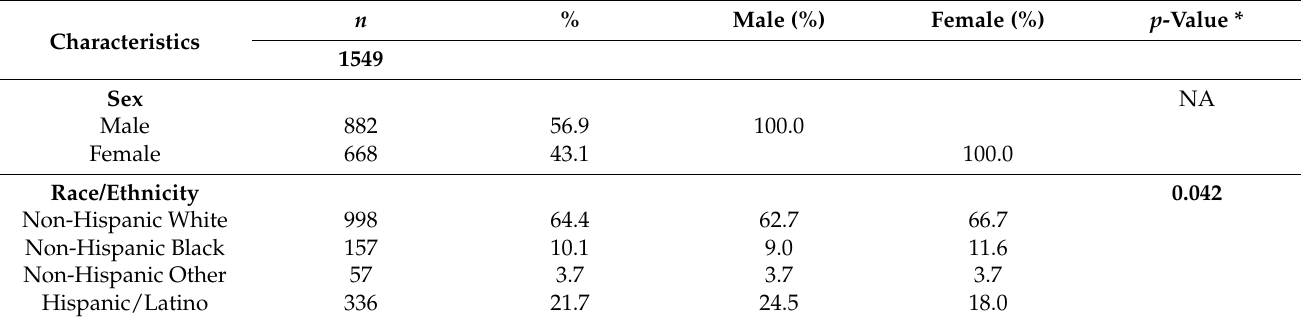
Table 1. Participant Characteristics, Overall and by Sex—Quantitative